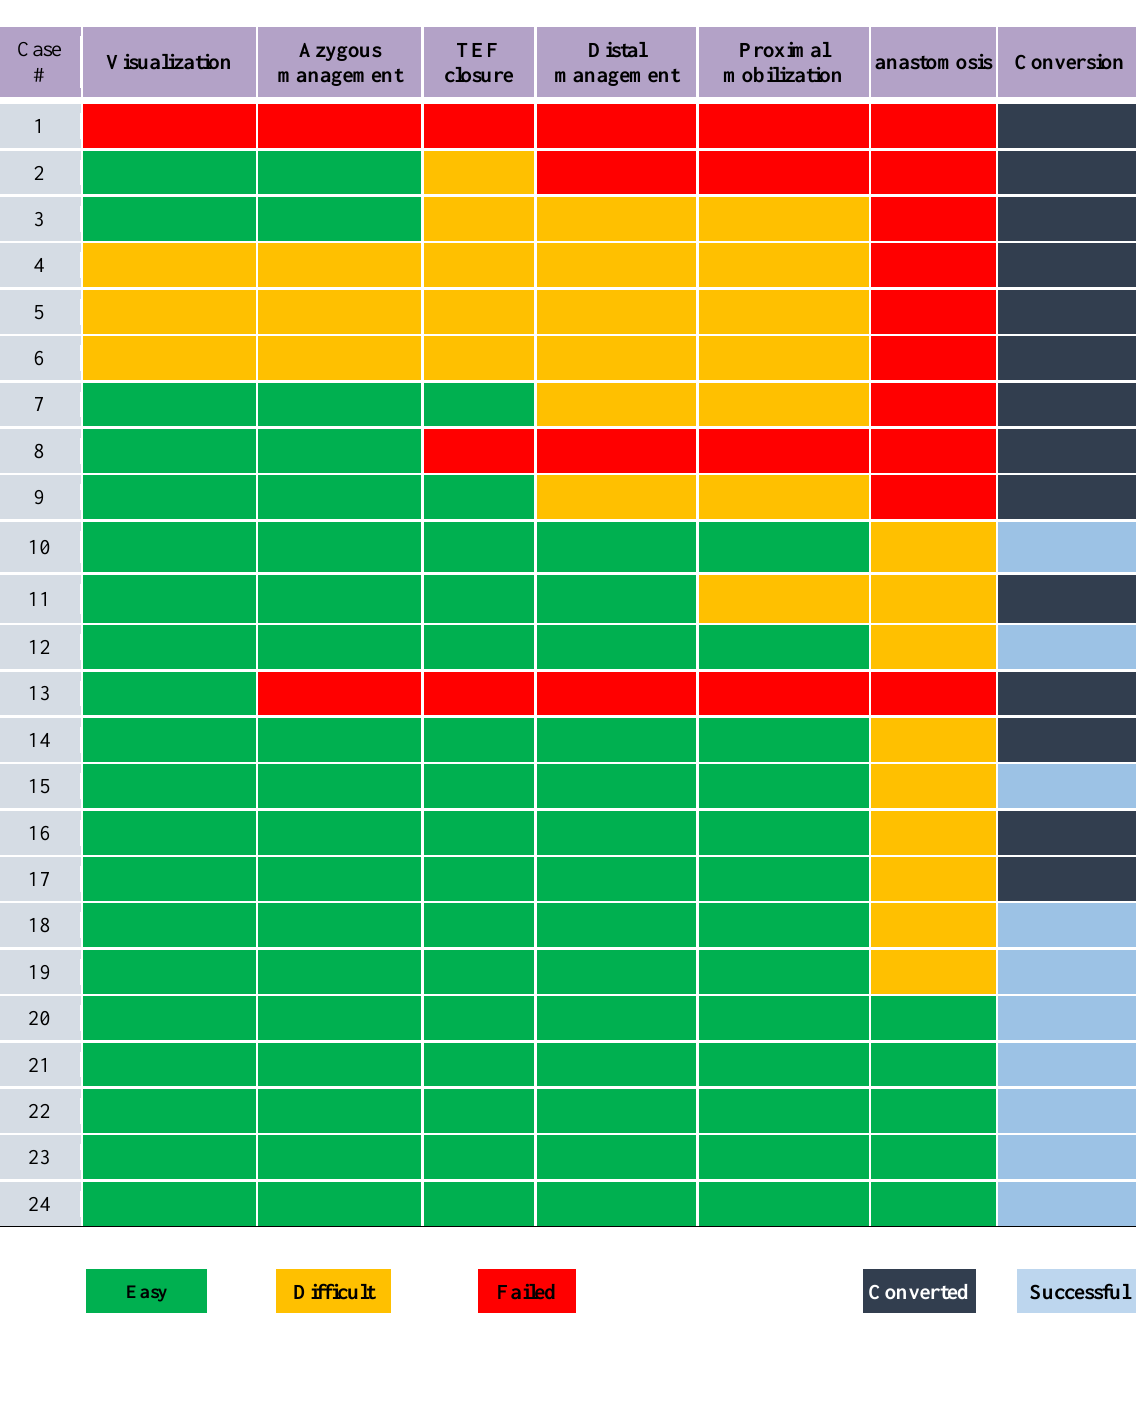
Table 1: learning curve in the first experiences in thoracoscopic approach to EA+ TEF